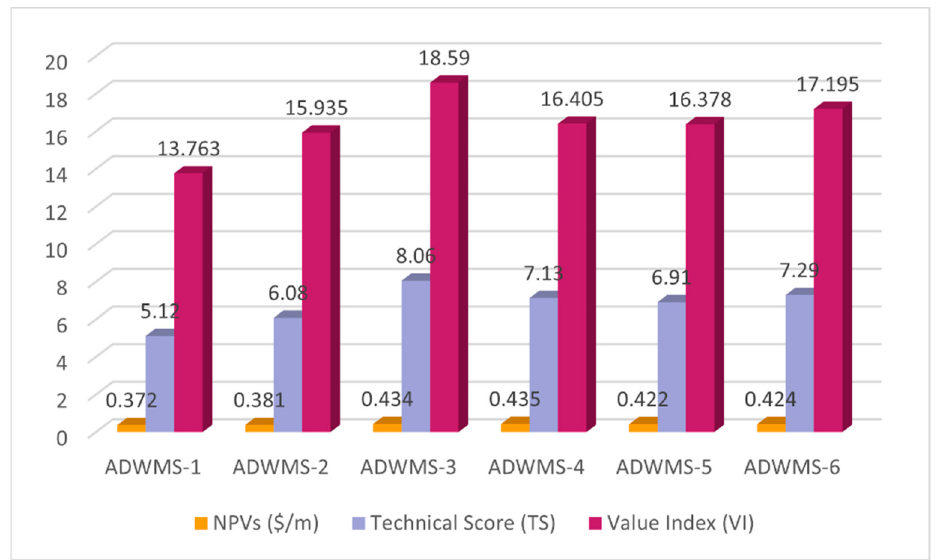
Figure 7. Total NPV, TS and VI for ADWM strategies.